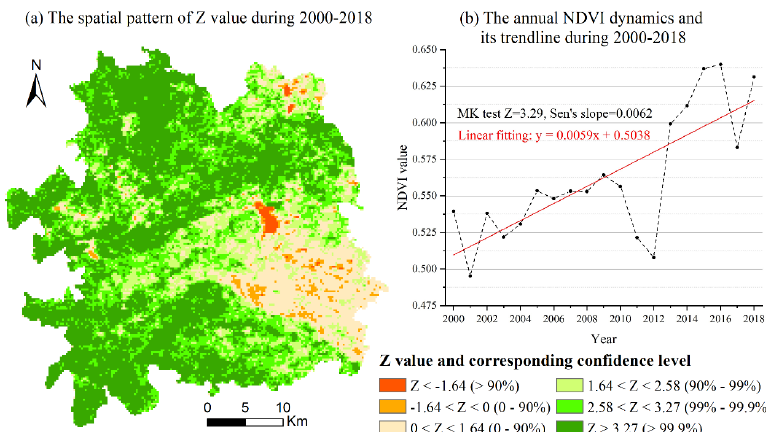
Figure 4. ( a ) The spatial pattern of the Z values and related confidence levels. When Z > 0, an increase trend could exist; while when Z < 0, a decrease trend could exist. Normally, when a grid has a